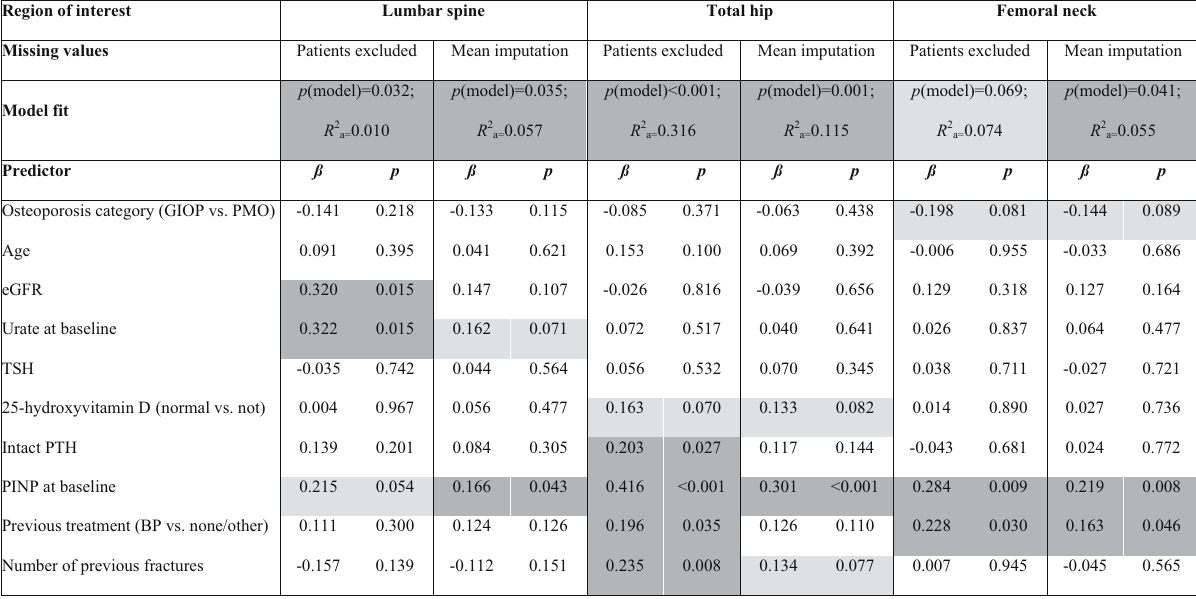
Table 3: Summary of multiple linear regression models for predicting increase in BMD in the fi rst 12 months ( n = 168 patients who had completed the treatment ) kcenlaromeFpihlatoTenipsrabmuLtseretnifonoigeR Missing values